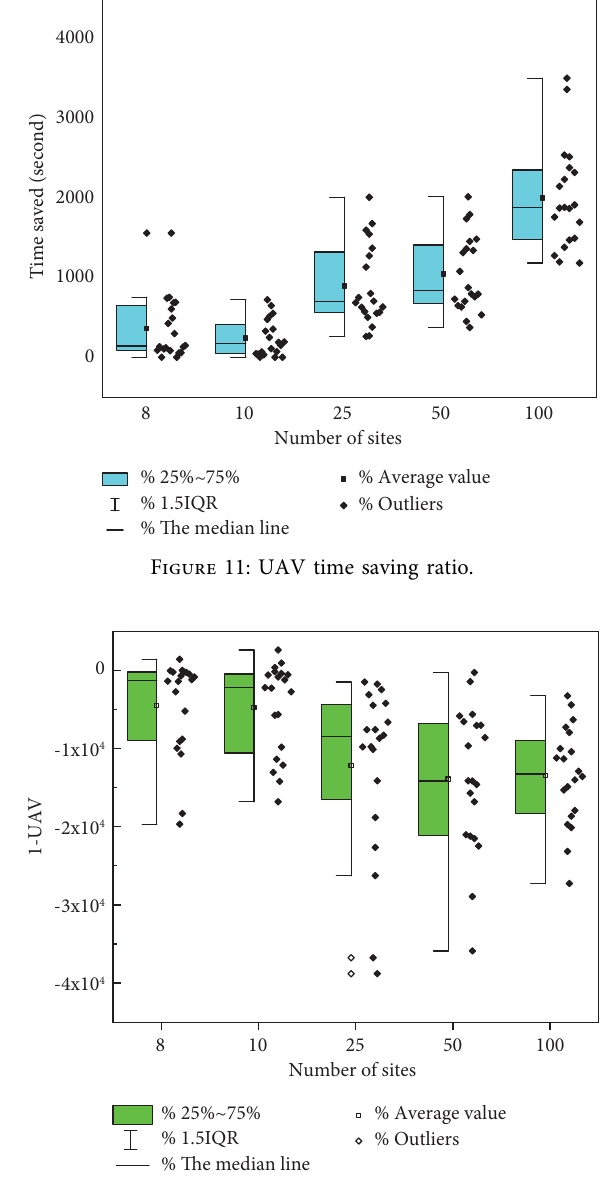
Figure 12: 1-UAV time saving